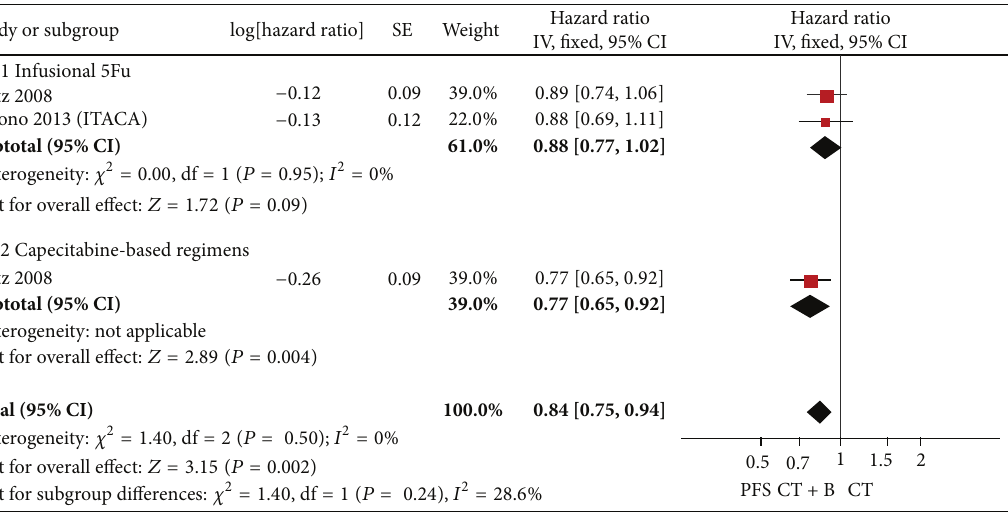
Figure 5: Fixed effect model on HR of PFS in the most used combination chemotherapy. The beneficial HR of PFS in standard first-line chemotherapy is symbolized by a solid diamond at the bottom of the forest plot and the width of which represents the 95% CI.